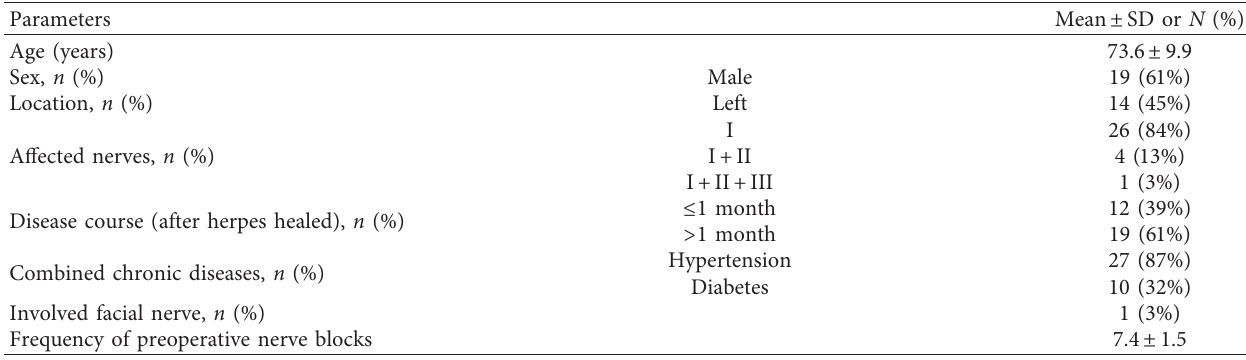
Table 1: Characteristics of the patients.